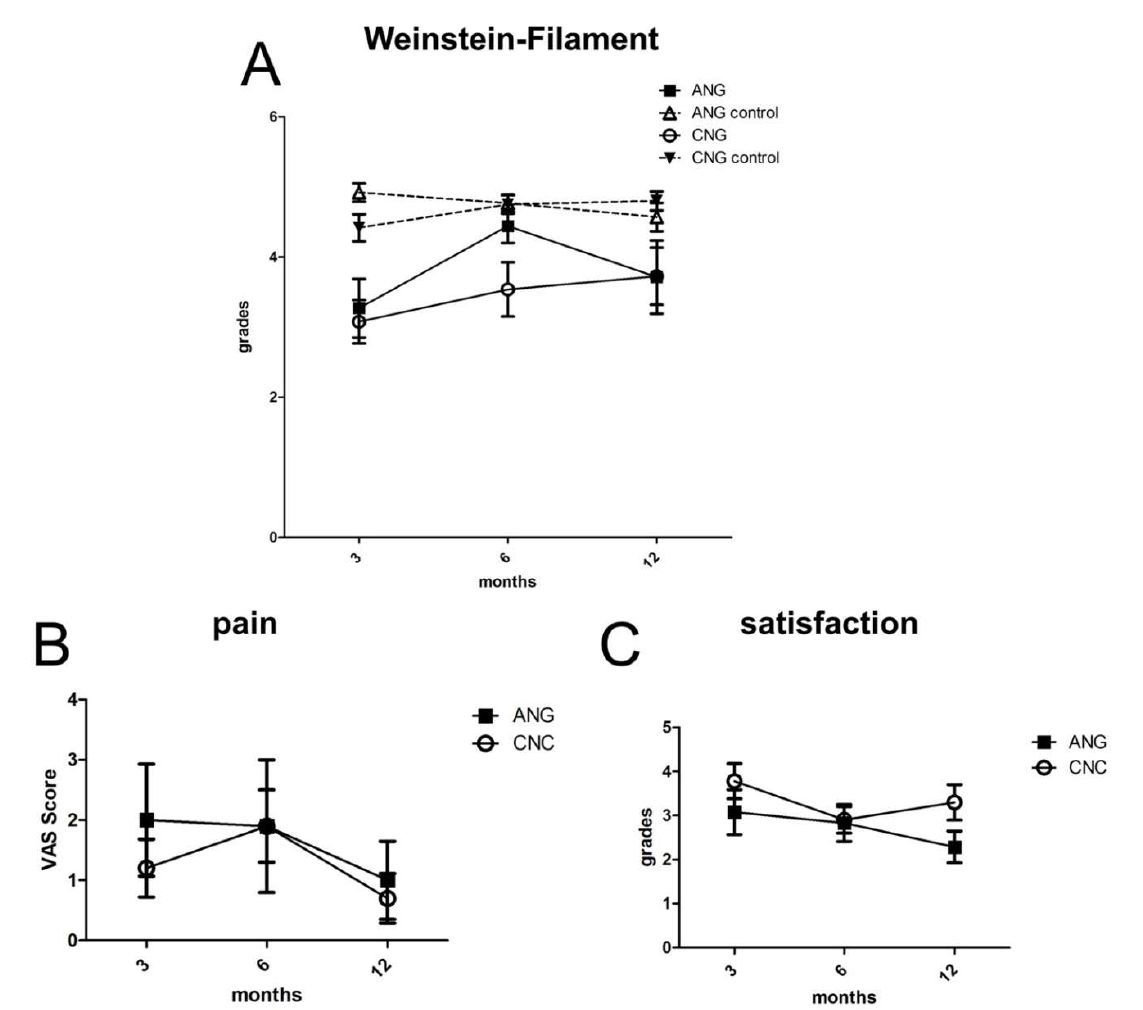
Figure 5. Semmes Weinstein Monofilament Test, pain assessed by the VAS score, and patient satisfaction. Semmes Weinstein Monofilament Test exposed no significant differences between ANG and CNC over the regeneration period. After twelve months of regeneration, CNC showed similar clinical results compared to ANG ( A ). Neither ANG nor CNC severe pain was assessed ( B ). Furthermore, reasonable patient satisfaction was seen after six and twelve months without presenting significant differences between ANG and CNC ( C